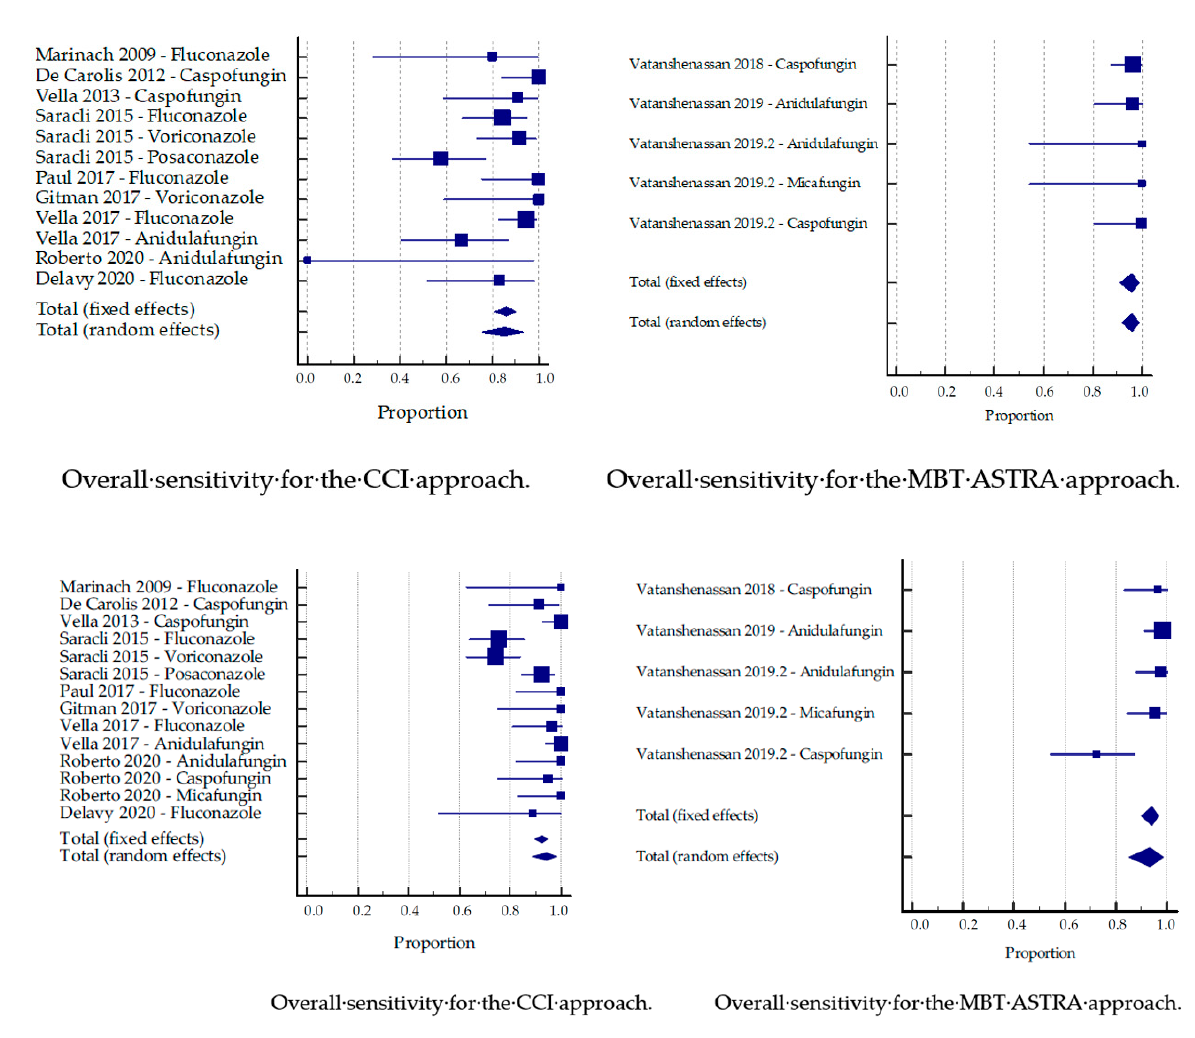
Figure 2. Sensitivity and specificity by technical